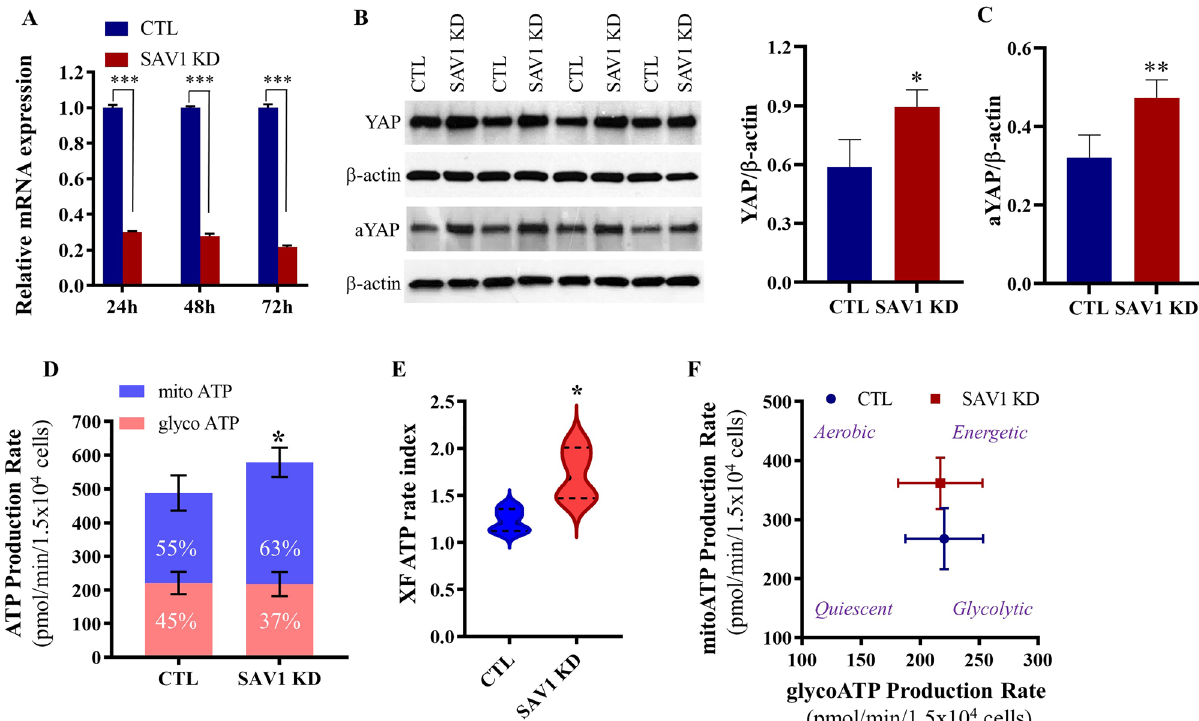
Figure 1. SAV1 KD in C2C12 myoblasts enhanced cell ATP production rate. ( A ) RT-qPCR indicates that the relative expression level of SAV1 mRNA was significantly suppressed after transfection of C2C12 myoblasts with SAV1 siRNA (SAV1 KD) at 24, 48, and 72 h as compared to negative control siRNA (CTL). Unpaired t test; data are mean ± SD; n = 3 independent assays; ***p < 0.001. ( B ) Representative western blot images show total YAP and the non-phosphorylated active form of YAP1 (aYAP) protein levels at 72 h after siRNA transfection. β-actin was used as a loading control. ( C ) Semiquantitative analysis shows a significant increase in YAP and aYAP in SAV1 KD cells compared with CTL cells. Unpaired t test; data are mean ± SD; n = 4; *p < 0.05, **p < 0.01. ( D ) Concurrent mitochondrial ATP and glycolytic ATP production rate in real-time under basal conditions. SAV1 KD cells showed a higher contribution of ATP production by mitochondrial oxidative phosphorylation than did CTL cells. ( E ) An increase of XF metabolic rate index (the ratio of mitoATP/glycol ATP) in SAV1